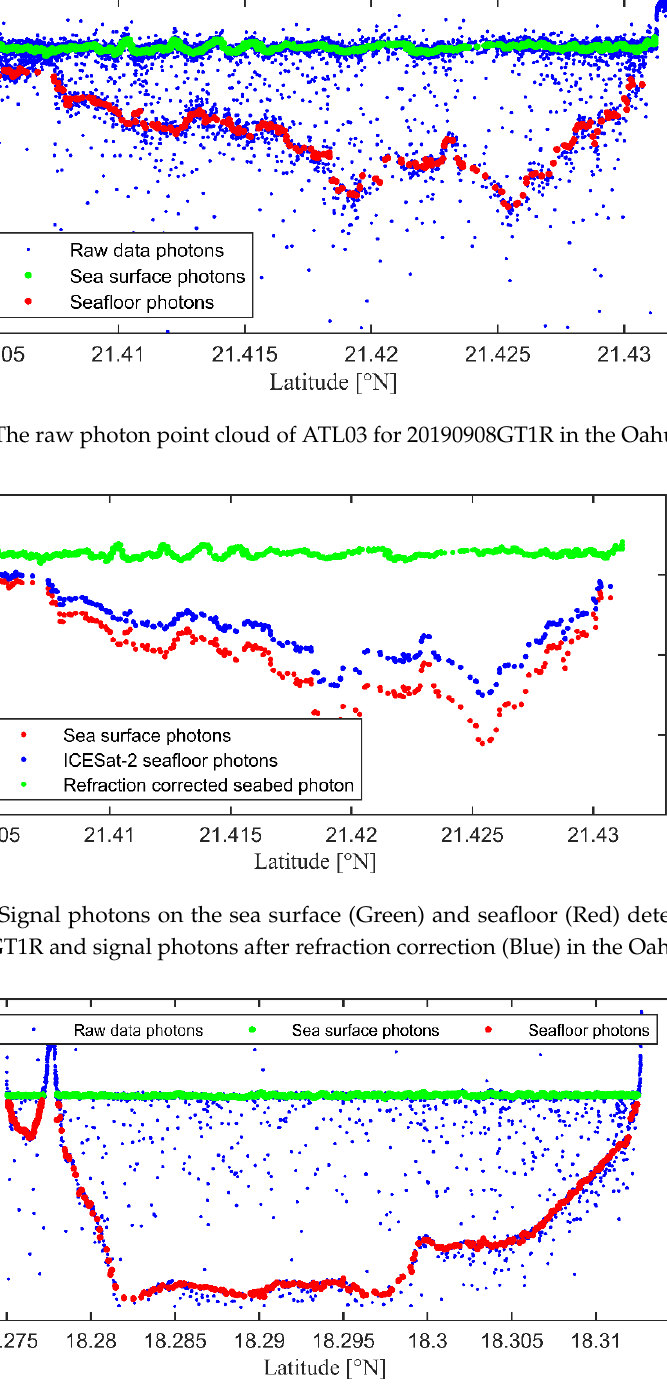
Figure 10. Signal photons on the sea surface (Green) and seafloor (Red) detected from ATL03 for 20190221GT1L and signal photons after refraction correction (Blue) in the St. Thomas area. Figure 11. Detection results of reflected photons on the sea surface and seabed in the Oahu area; ( a ) 20190908GT1L; ( b ) 20190908GT1R; ( c ) 20200614GT2L; ( d ) 20201205GT1L. Figure 12. Detection results of reflected photons on the sea surface and seabed in the St. Thomas area; ( a ) 20181122GT1L; ( b ) 20181122GT1R; ( c ) 20181122GT2R; ( d ) 20181122GT3R; ( e ) 20190221GT1L; ( f ) 20190221GT2L.